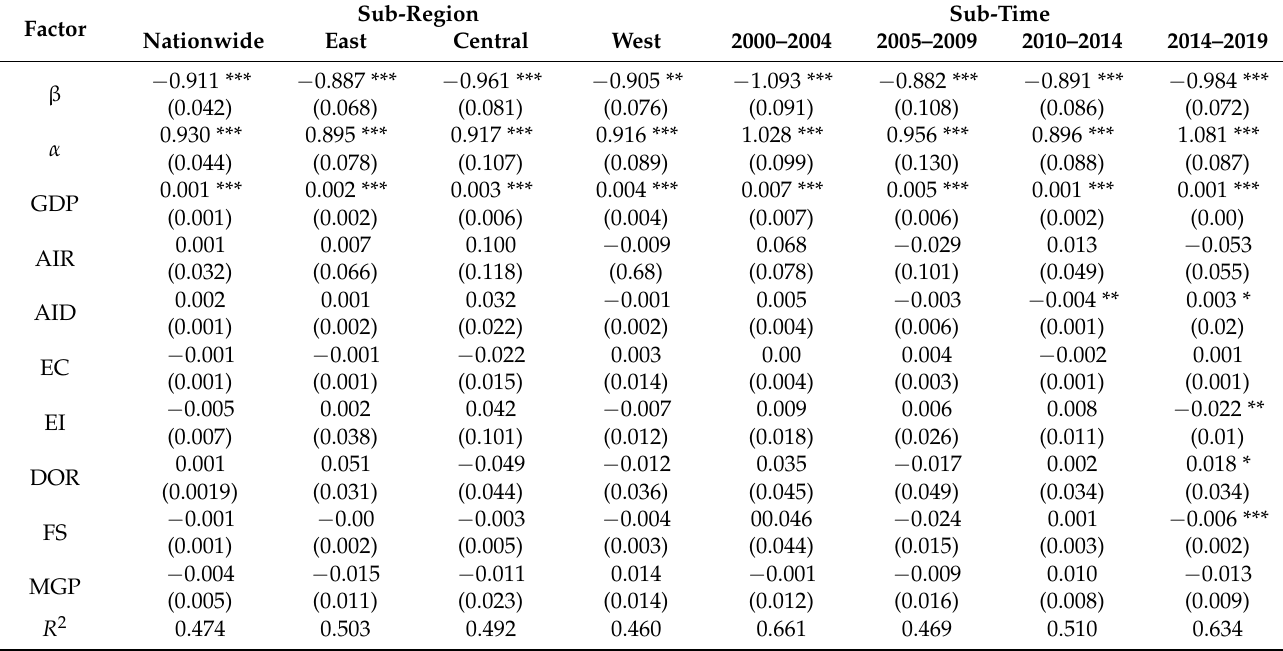
Table 6. Conditional β convergence results for AGTFP.